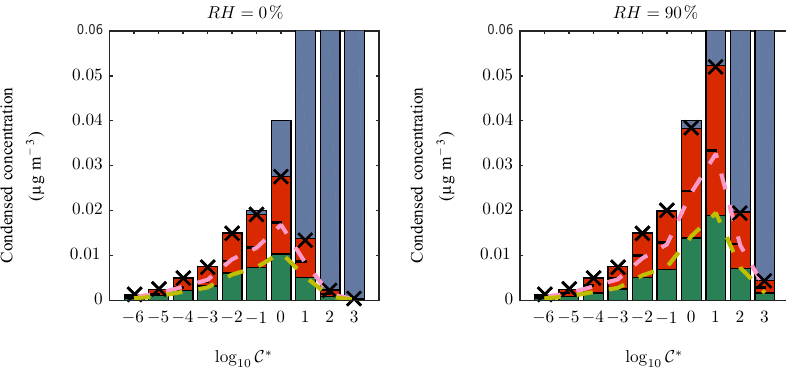
Figure 12. Same as Fig. 11, but the first mode has a median diameter of 50nm and a number concentration of 200cm − 3 . The second mode has a median diameter of 125nm and a number concentration of 50cm − 3 . The geometric standard deviations are 0.5 and